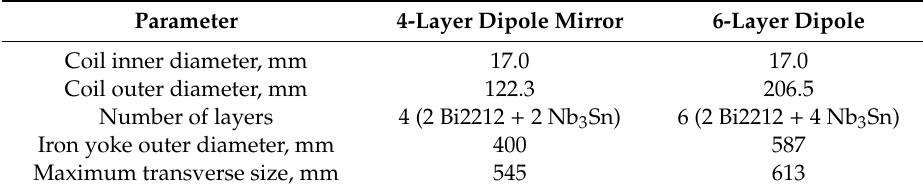
Table 5. Geometrical parameters of hybrid test configurations.